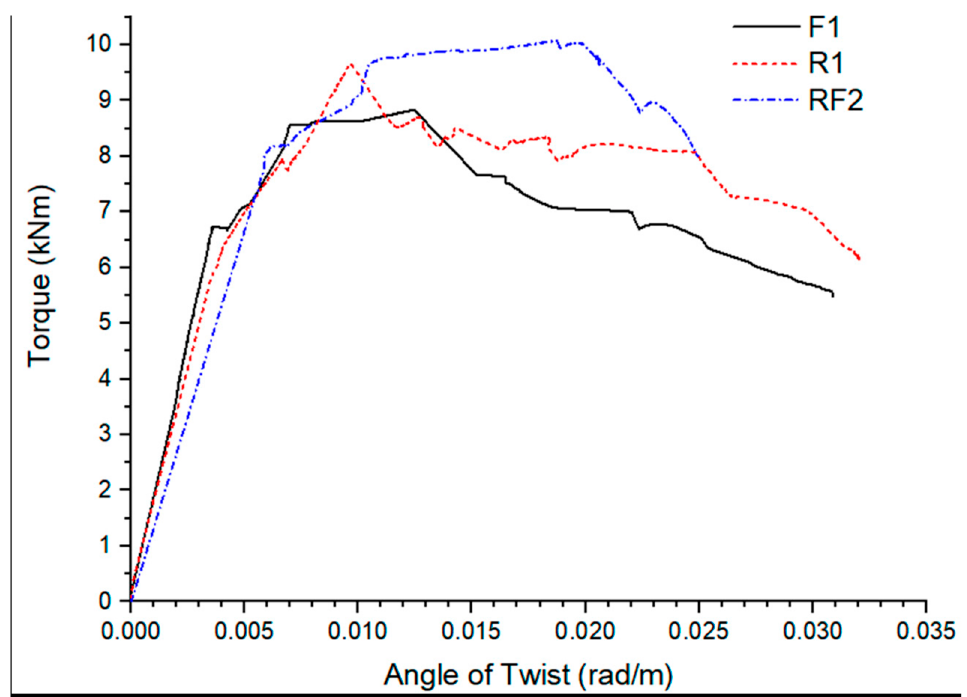
Figure 3. Torque vs. angle of rotation comparison of solely fibre reinforcement, conventional reinforcement, and hybrid reinforcement comprising of fibres and typical reinforcement [39].